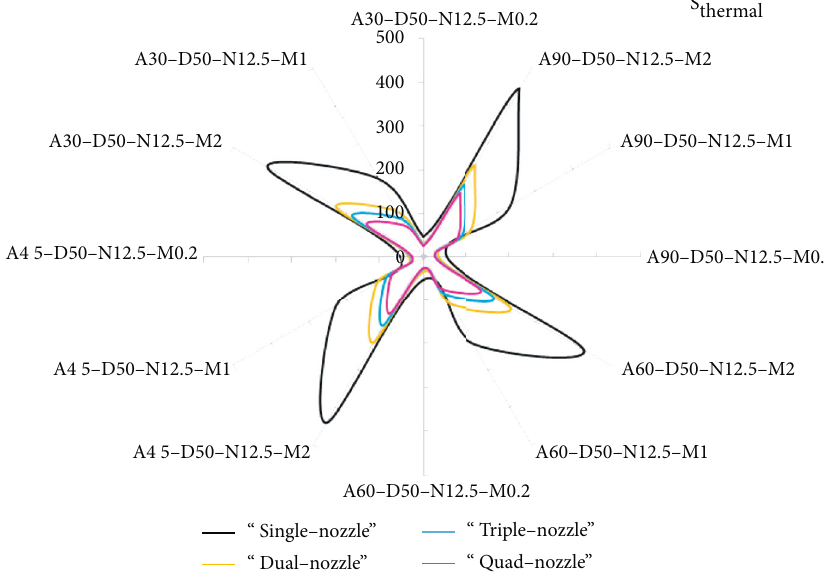
Figure 3: Entropy generation due to thermal